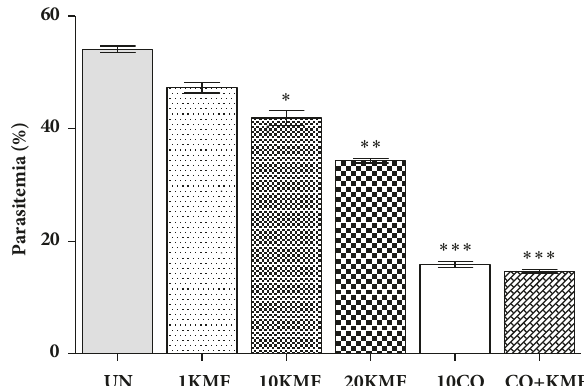
Figure 3: Antimalarial effect of kaempferol on PbANKA in a curativetest.GroupsofICRmice(3micepergroup)wereinoculated with 1x10 7 PbANKA parasitized erythrocytes by IP injection for 4 days (days 0-3). Starting on day 4, the mice were given 1, 10, and 20mg/kg of kaempferolby oral gavagefor 4 consecutivedays (day 4- 7).Untreatedandpositivecontrolmicereceived10 ml/kgofDWand 10mg/kg of CQ, respectively. A combination treatment of 10mg/kg of CQ and 20mg/kg of kaempferol was also administered. On day 8, parasitemia was determined by microscopic examination of Giemsa stained thin blood smears. ∗ P < 0.05, ∗∗ P < 0.01, and ∗ ∗ ∗ P < 0.001, compared to untreatedcontrol. UN; untreatedcontrol, 1KMF; 1 mg/kg of kaempferol, 10KMF; 10mg/kg of kaempferol, 20KMF; 20mg/kg of kaempferol, and 10CQ; 10mg/kg of chloroquine. The results are expressed as mean ±